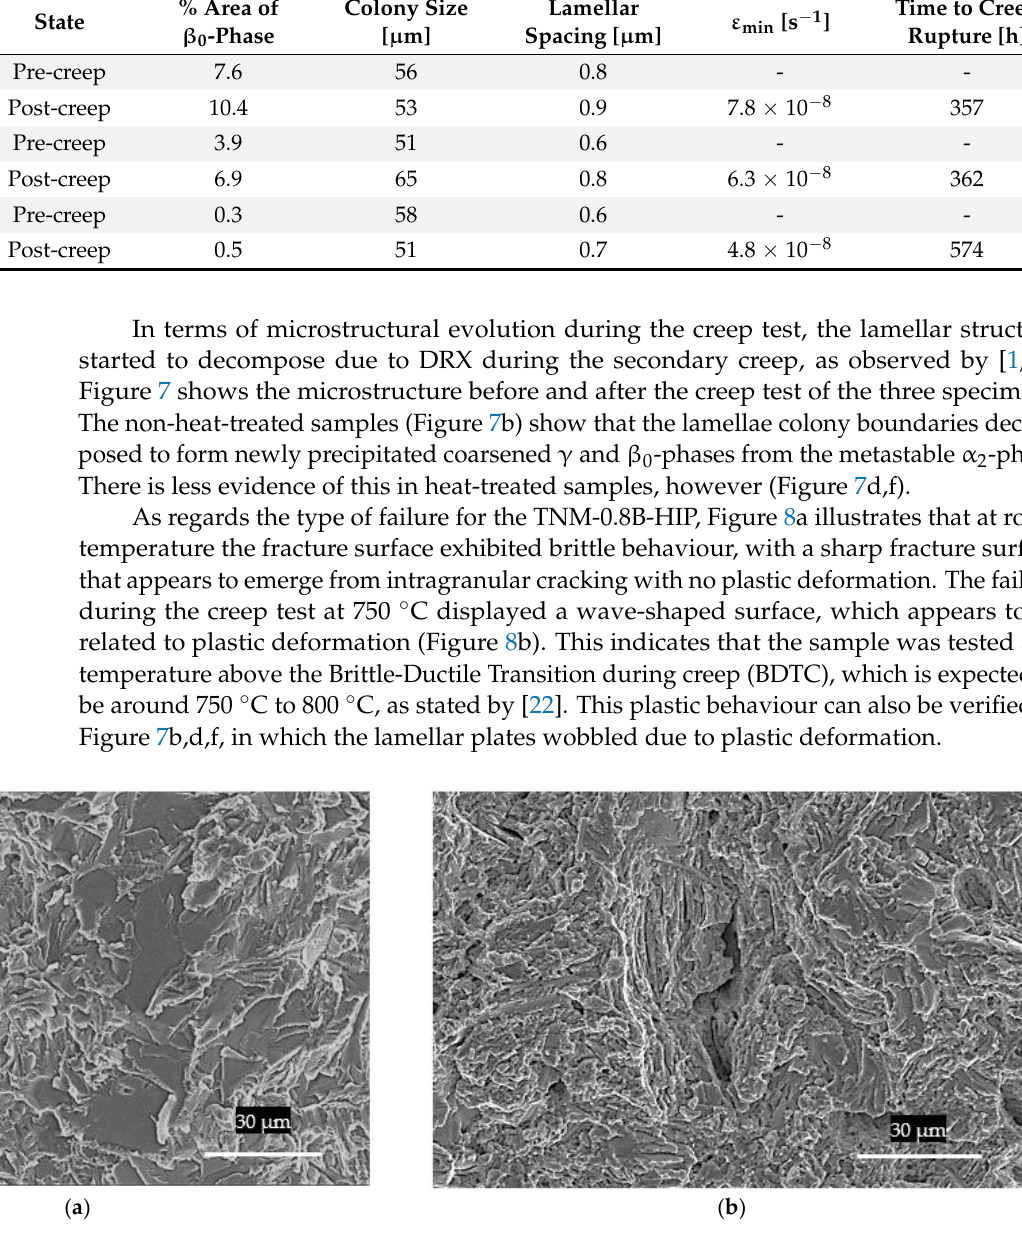
( c ) Figure 9. SEM post-creep; ( a ) TNM-0.8B-HIP, ( b ) TNM-0.8B-HIP-HT, ( c ) TNM-1.5B-IHT. 4. Discussion The main goal of this study is to establish an advanced manufacturing route for TiAl alloys, by integrating HIP and HT into a single step, so-called IHT. For this purpose, the process parameters and workflow were adjusted to develop the required microstructure detailed in references [23,25]. Then, the developed material was creep tested to validate its performance. Overall, alloy TNM-1.5B-IHT presents superior creep strength compared to the other studied TNM alloys, thanks to its least variation of microstructural parameters during creep. To meet this goal, a microstructure with lamellar colonies in the range of 50 – 100 μm, nanometre -spaced lamellae, and a low volume fraction of globular γ -grains and no globular β 0 -grains, was developed. From [23,25] previous studies, this superior perfor- mance is derived from the adjustment of the chemical composition, the optimization of the solidification cooling rate of the casting process and the application of the integrated HIP heat treatment IHT developed in this work.